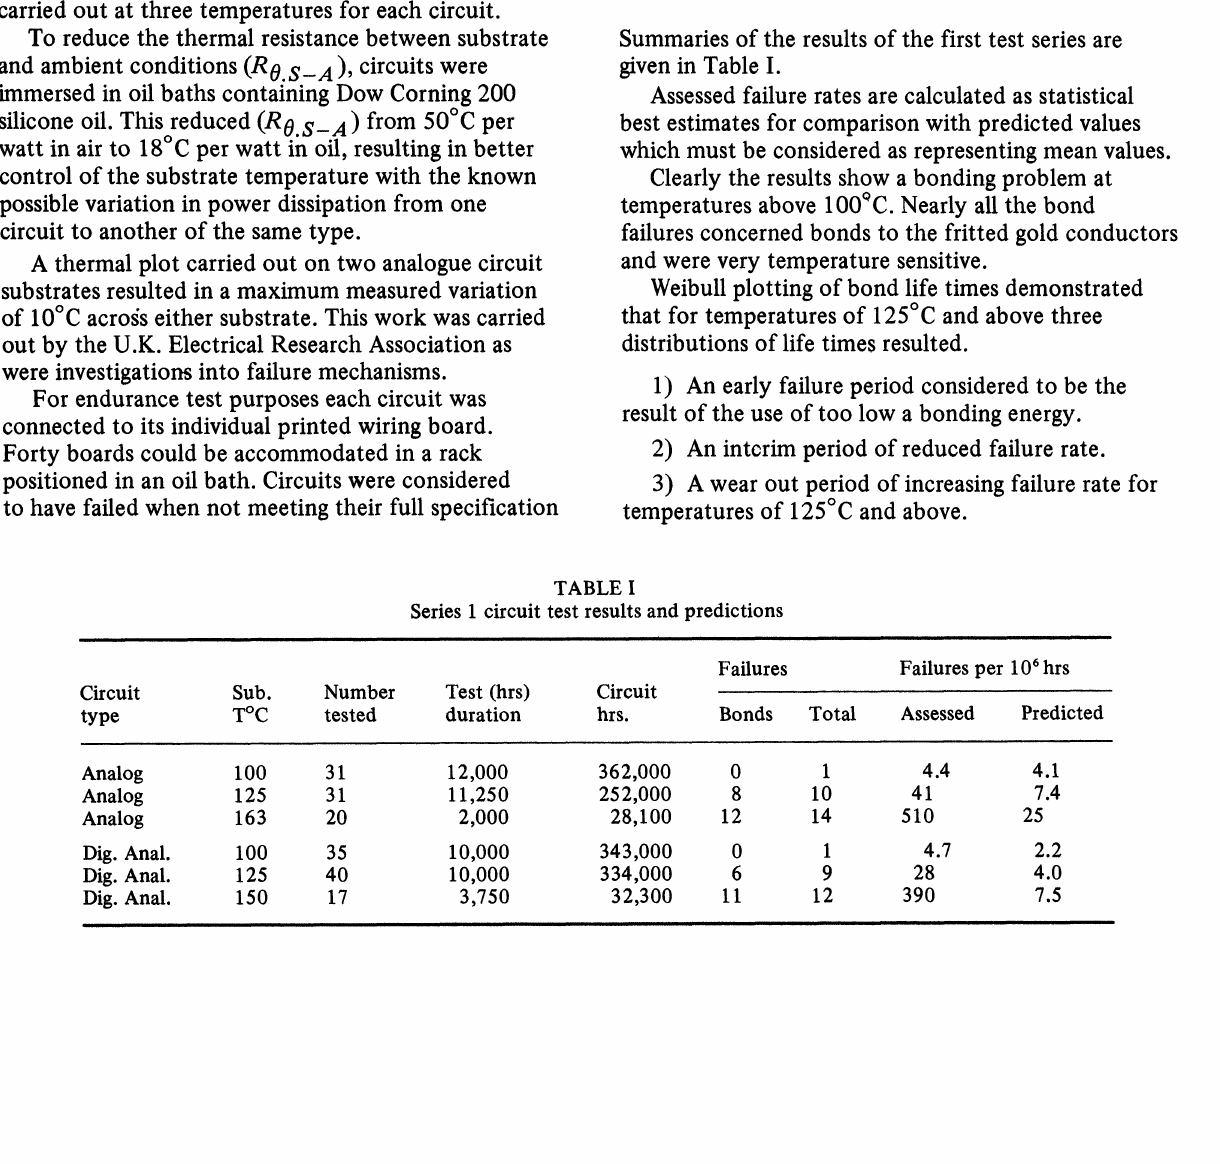
TABLE Series circuit test results and